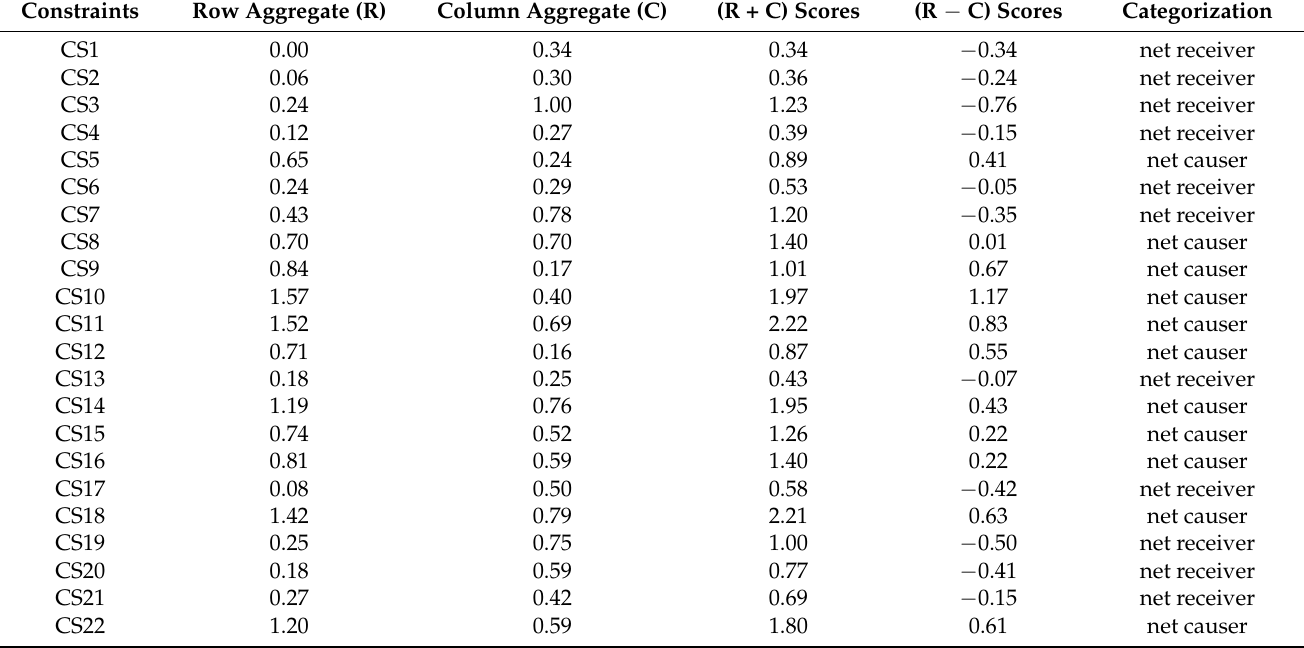
Table 6. The effect